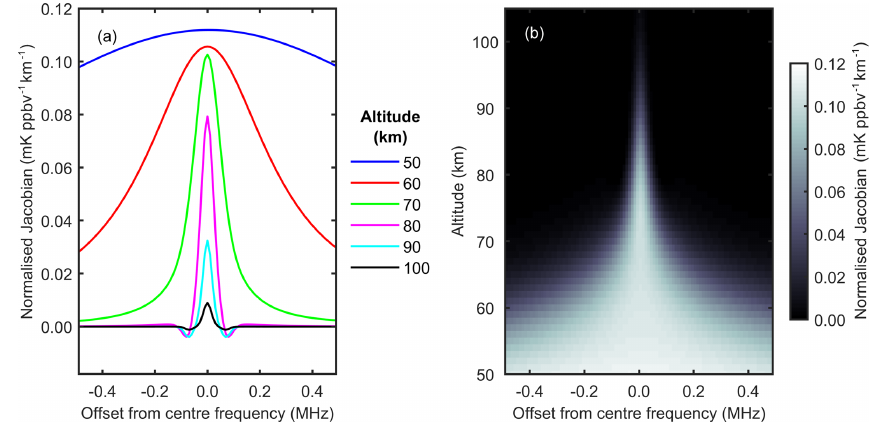
Figure 13. Rows of the Jacobian describing the hydroxyl (OH) retrieval, normalised by the layer thickness of the retrieval grid. The data are for retrievals from simulated 6h observations of the OH 13.441GHz emission line using a ground-based radiometer with vertical polarisation, 1mK baseline noise level, 10kHz frequency resolution, 82 ◦ zenith angle, and 0 ◦ azimuthal angle (i.e. north-pointing) located at Kilpisjärvi (69 ◦ 03 (cid:48) N, 20 ◦ 48 (cid:48) E), Finland, in clear-sky December conditions. Rows of the Jacobian matrix for selected altitude levels are plotted in (a) . The grey scale in (b) indicates the values of the Jacobian